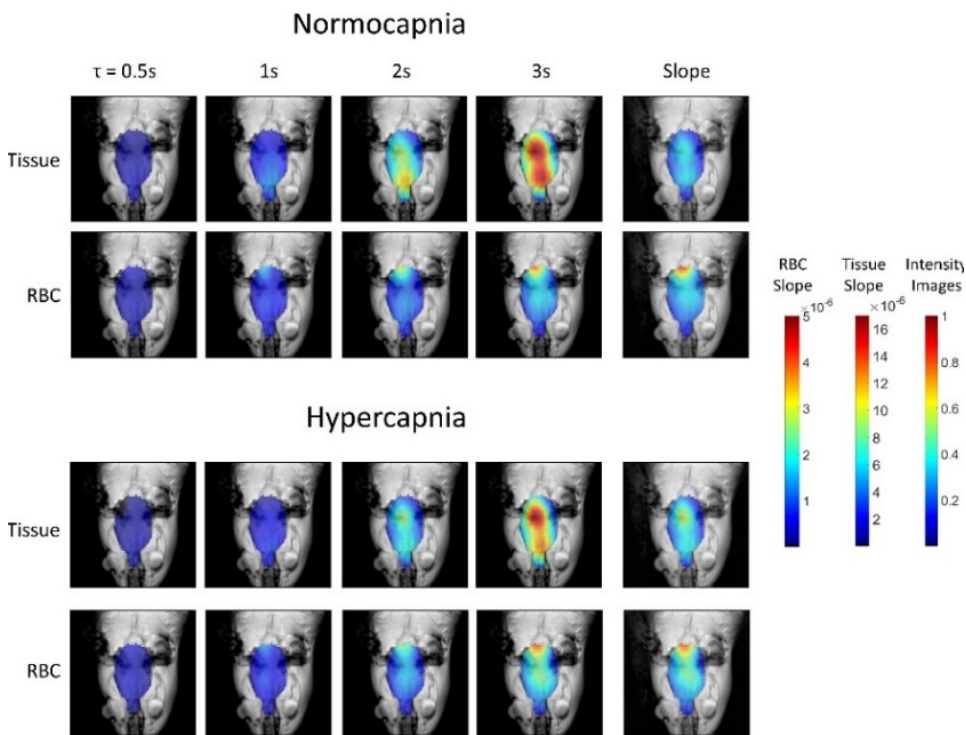
Figure 31. Spectrally resolved of HXe dissolved in the rat brain at various washout times during normocapnic (top) and hypercapnic (bottom) ventilation. Reprinted with permission from Friedlander, et al. ( Magn Reson Med 2021, ref. [106]).